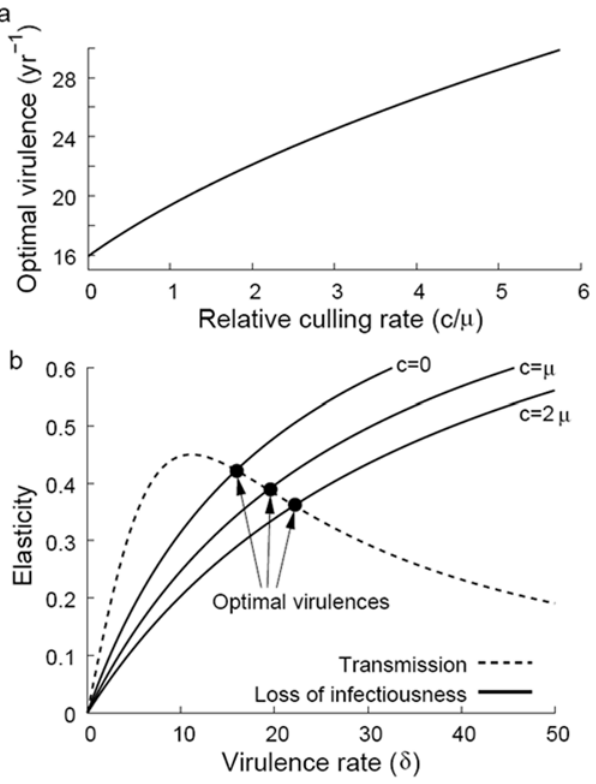
Figure 7. (a) The increase in optimal virulence with culling rate. Virulence is the rate of infection-mediated host mortality. Optimal virulence is a function of culling rate that maximizes overall transmission, i.e. R 0 . (b) Optimal virulence coincides with the point where the virulence elasticity of the transmission rate is equal to the virulence elasticity of the rate of infectiousness loss. Increases in the culling rate do not affect the elasticity of transmission but always diminish the elasticity of infectiousness loss, so the optimal virulence increases as the culling rate increases. The virulence elasticity of infectiousness loss is plotted for culling rates c ~ 0 , c ~ m , and c ~ 2 m